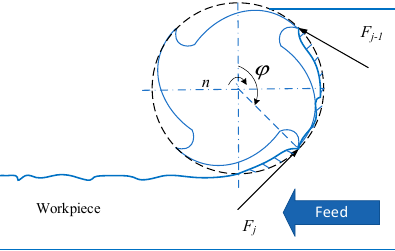
Figure 8. Tool teeth generate workpiece surface when in contact with workpiece.